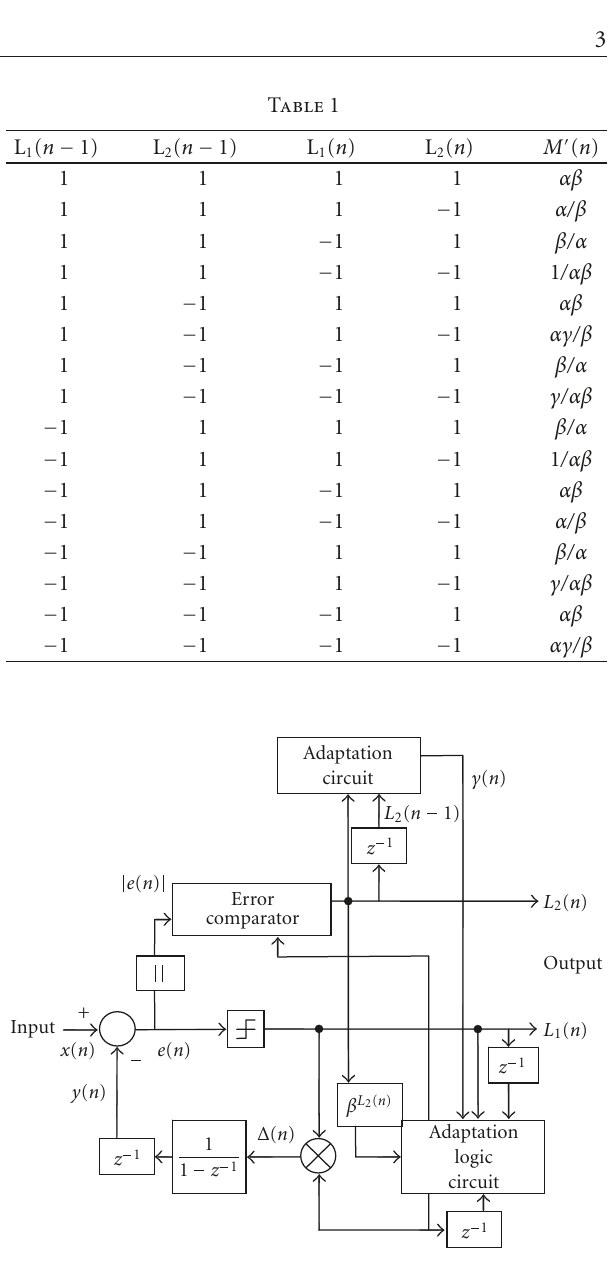
Figure 2: Block diagram of the proposed 2-bit ADM